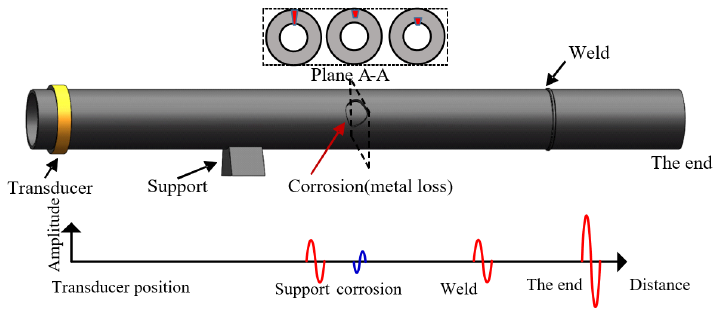
Figure 1. Schematic of guided wave propagating in the pipe inspection.